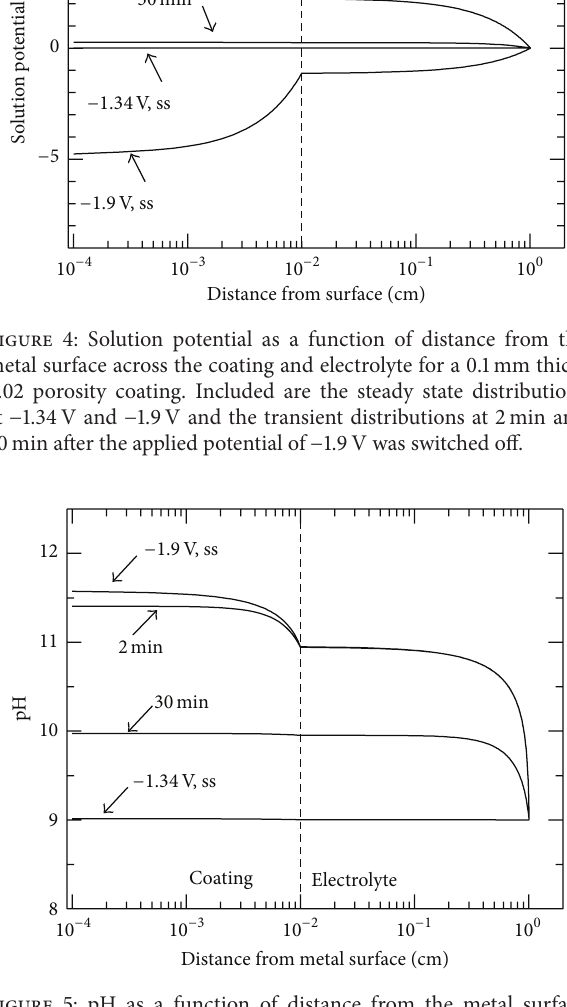
Figure 5: pH as a function of distance from the metal surface acrossthecoatingandelectrolytefora0.1 mm,0.02porositycoating. Included are the steady state distributions at − 1.34 V and − 1.9V and the transient distributions at 2 min and 30 min after the applied potential of − 1.9V was switched